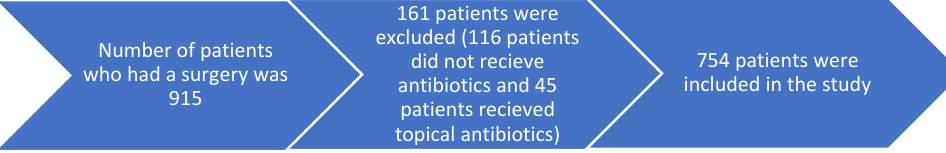
Figure 1. The number of patients included in this study.